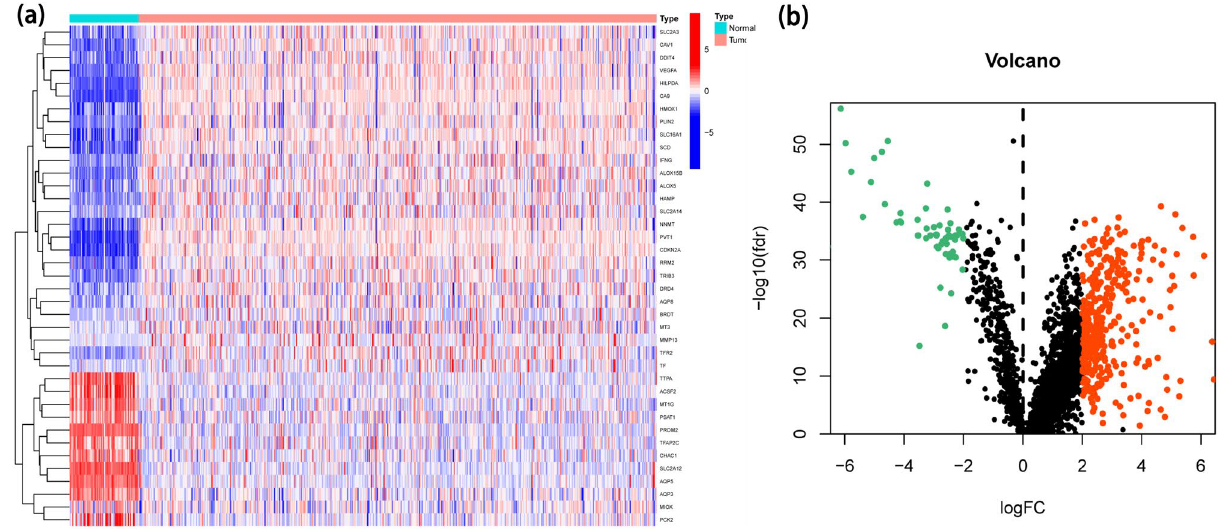
Figure 2. Identification of FA-DEGs and FA-DELs in ccRCC patients. ( a ) Heatmap for 39 FA-DELs. ( b ) The volcano plot of 433